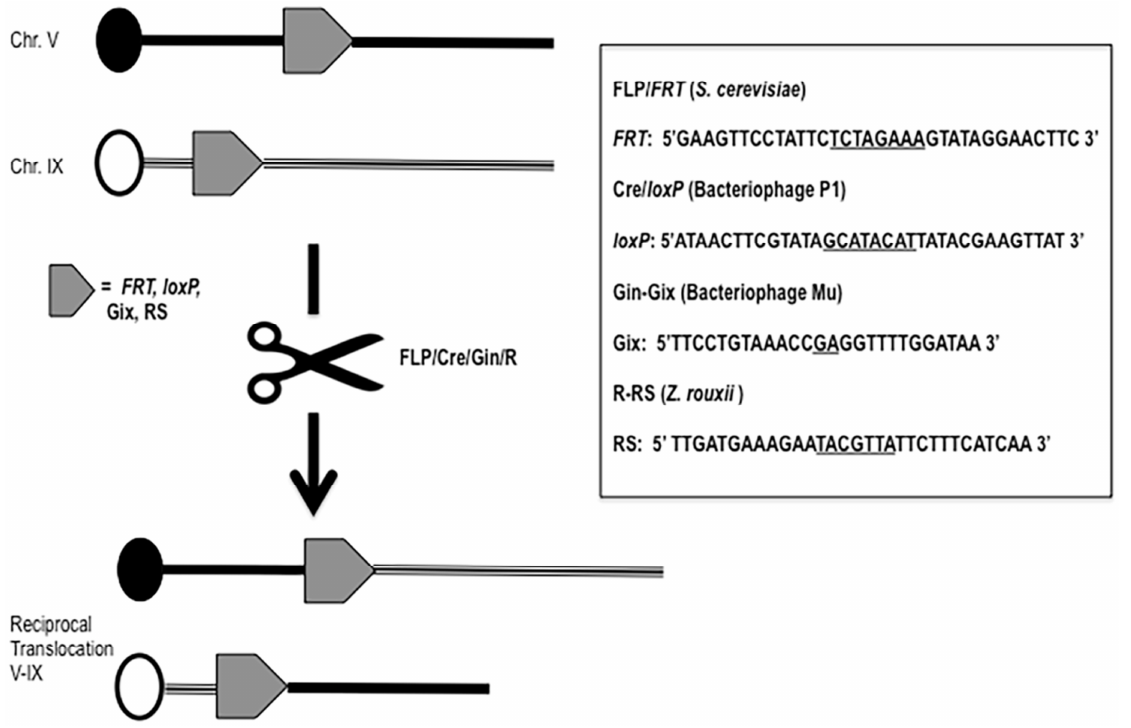
FIGURE 1: Scheme summarizing a reciprocal translocation event promoted by the most used recombinases. On the right, their recognition target sequences are reported. The asymmetric core regions are